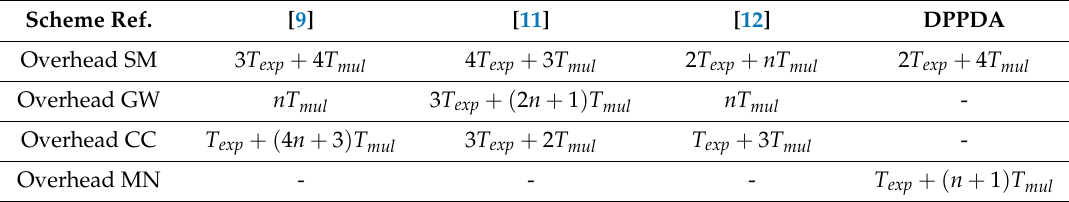
Table 3. Comparing computation complexity between the proposed scheme and other schemes. Scheme Ref.